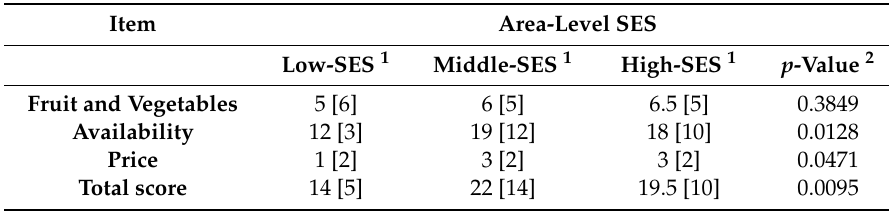
Table 6. Nutrition Environment Measures Survey in stores for Mediterranean contexts (NEMS-S-MED) scores by census tract-level socioeconomic